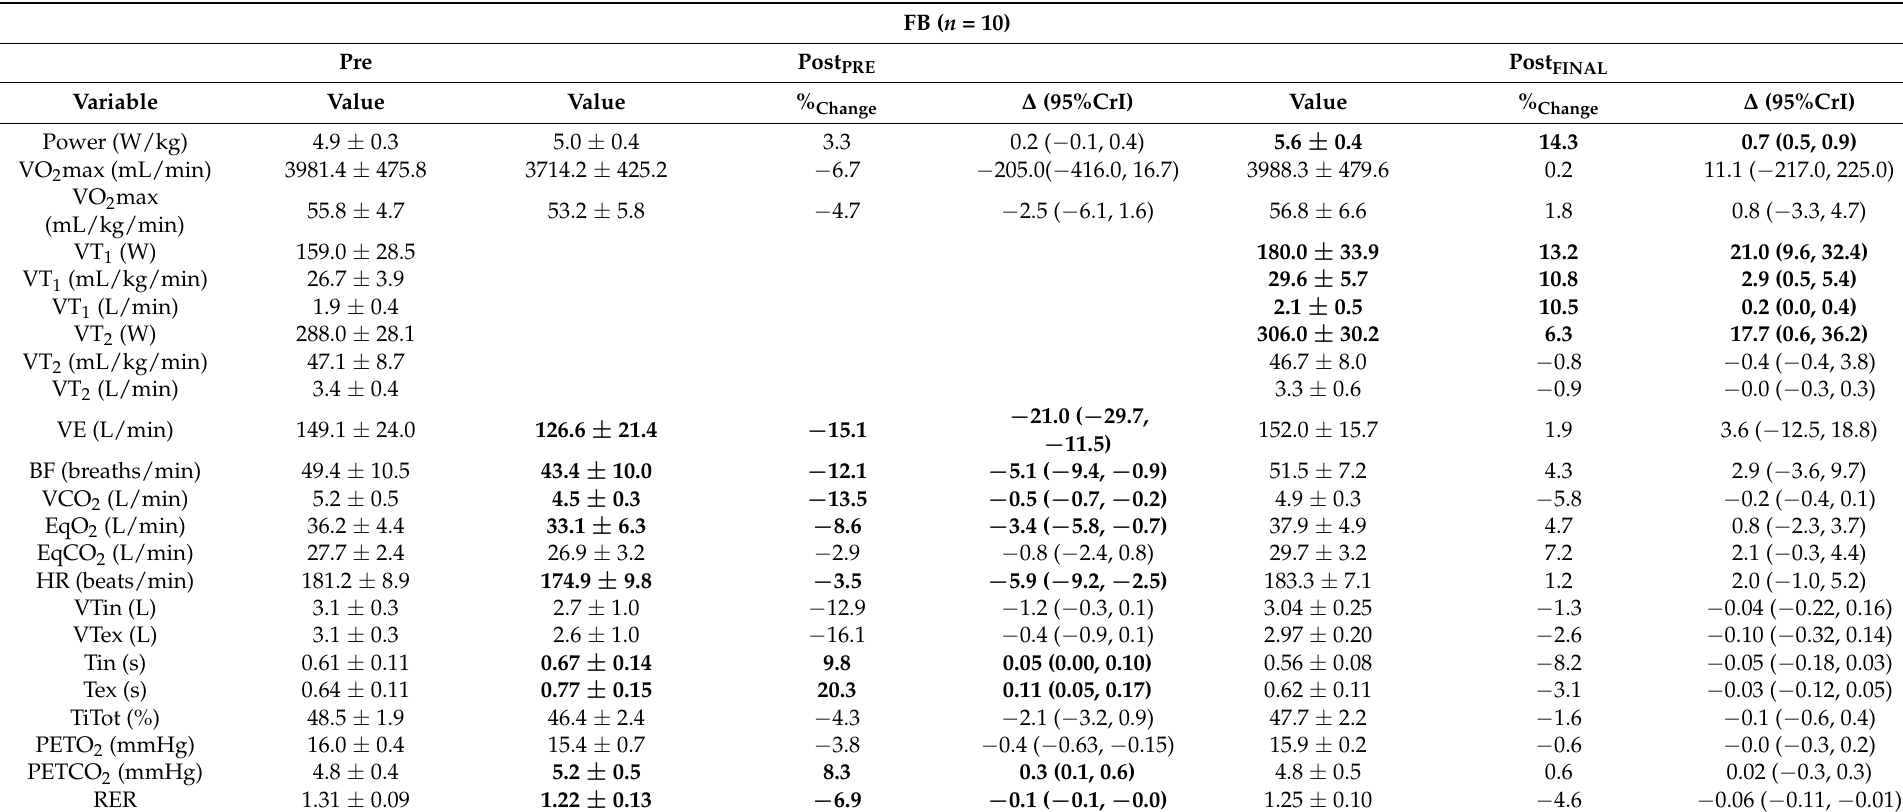
Table 2. Average of the maximum value obtained by the Feelbreathe group (FB) in each variable at the pre-training test (Pre-Value), value obtained in the post-training test at the same moment that the maximum in the pre-training test was obtained (Post PRE -Value), and maximum obtained at the post-training test (Post FINAL -Value). Percentage of change (% Change ), increment ( ∆ ), and 95% HDI are reported from Pre to Post PRE and from Pre to Post FINAL . FB ( n =